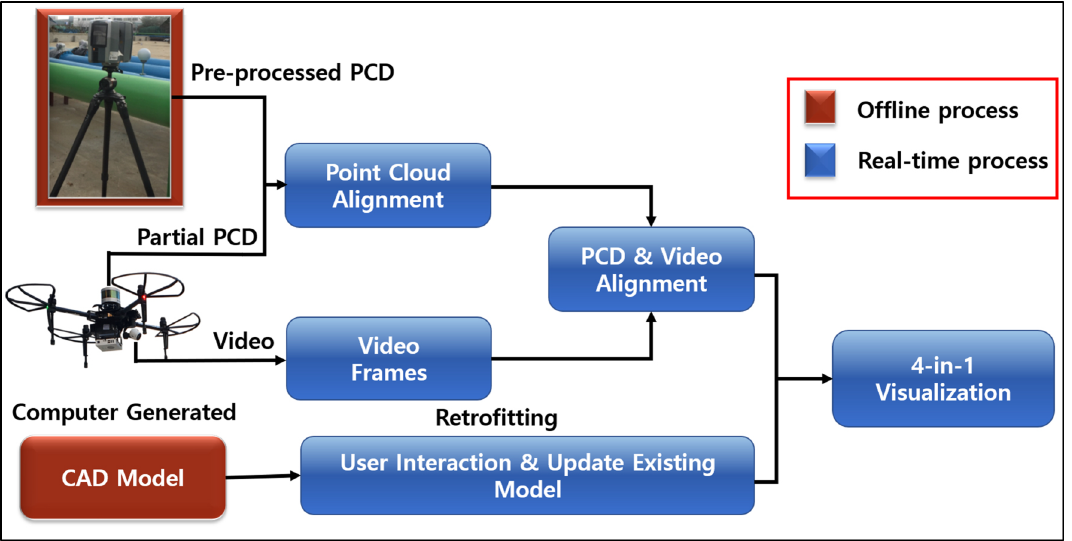
Figure 1. Overall representation of proposed